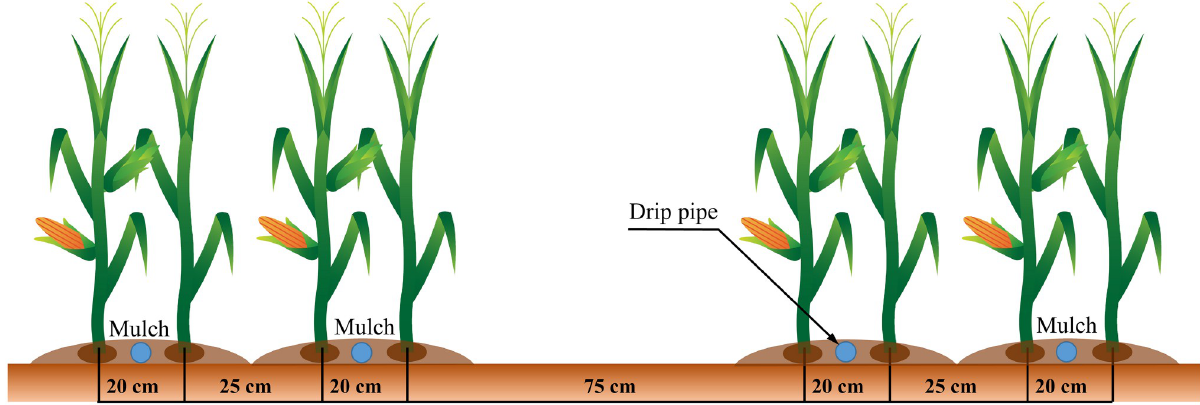
Fig 3. The narrow/wide row alternation for silage corn in experimental